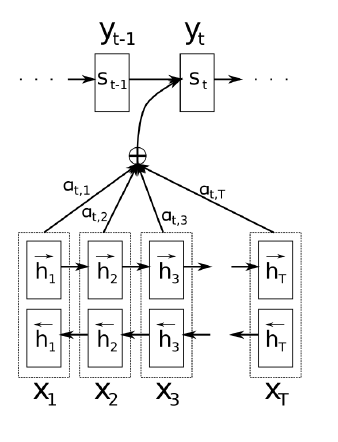
Schematic of the alignment model adapted from Bahdanau et al.